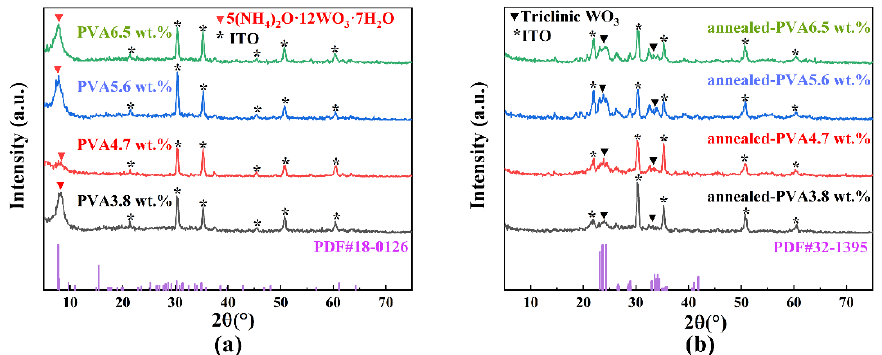
Figure 6. X-ray diffraction (XRD) patterns of films: ( a ) screen printing PVA + FSO ink formulas without annealing process, ( b ) screen printing PVA + FSO ink formulas with annealing process.